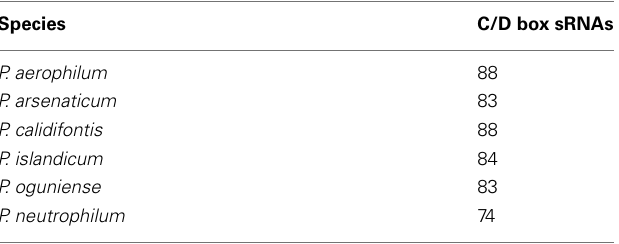
Table 1 | C/D box sRNA genes in each Pyrobaculum species based on transcriptional evidence or inferred by homology ( P. oguniense and P. neutrophilum ).